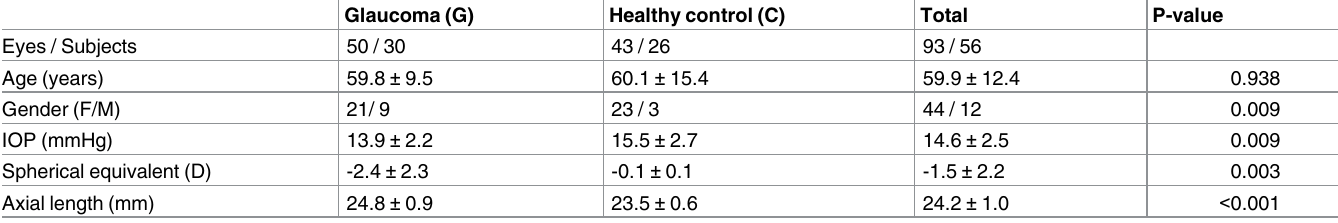
Table 1. Baseline characteristics of the groups.